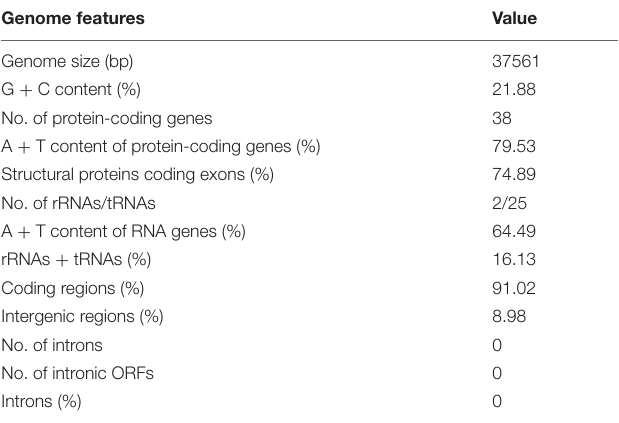
TABLE 1 | General features of Phytophthora nicotianae mitochondrial